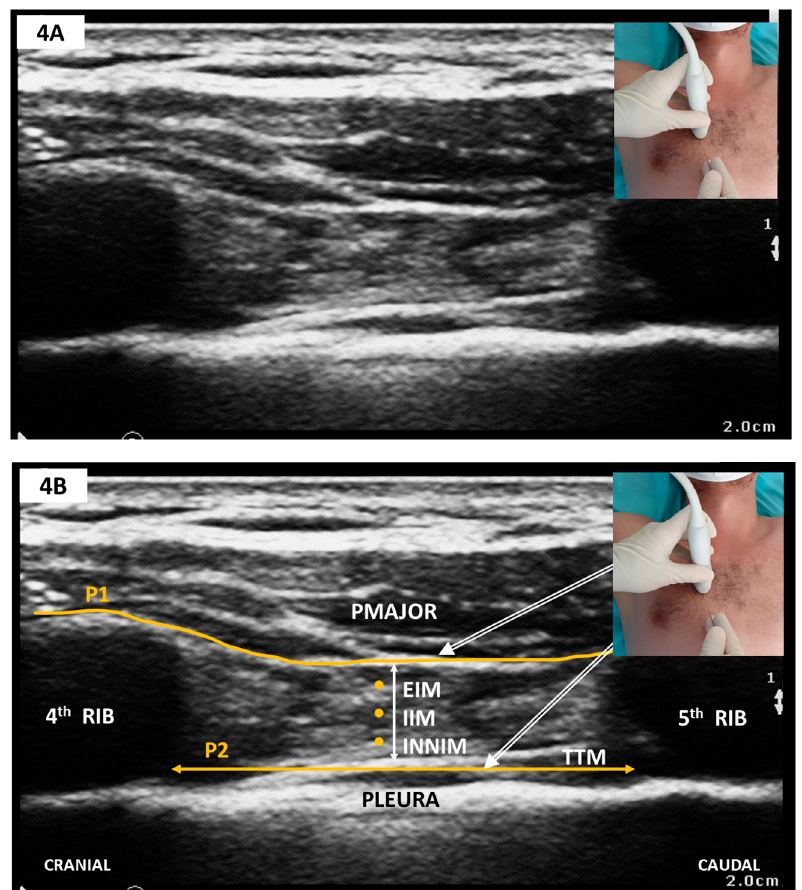
Figure 4. ( A ) Sagittal parasternal scan; ( B ) Sagittal parasternal scan with markings. Note that TTM appears as a hypoechoic band folding over the hyperechoic pleura. PMAJOR, pectoralis major muscle; EIM, external intercostal muscle; IIM, internal intercostal muscle; INNIM, innermost intercostal muscle; TTM, thoracic transversus muscle; P1, target plane for PIFB; P2, target plane for TTMPB.